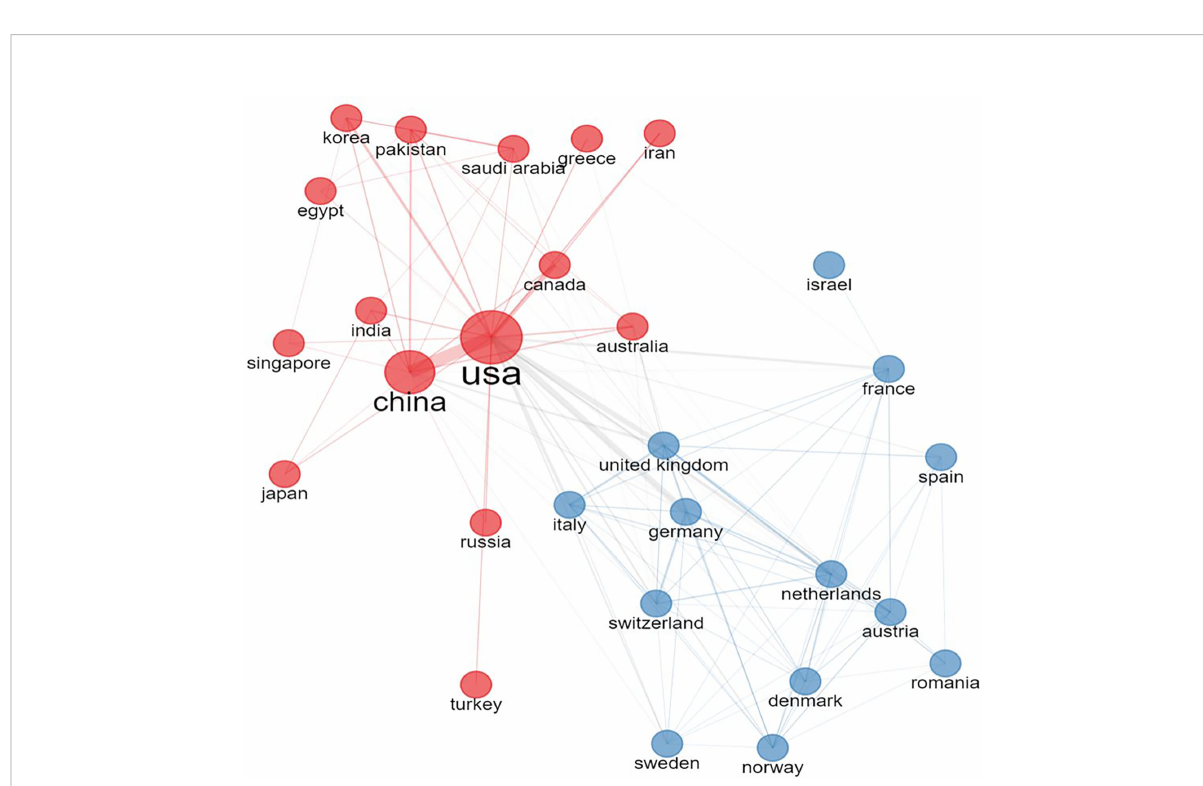
FIGURE 3 The collaboration network of different countries. All countries were divided into 2 groups according to collaborative strength. The larger the node is, the more productive the country is. The wider the line is, the stronger the collaboration